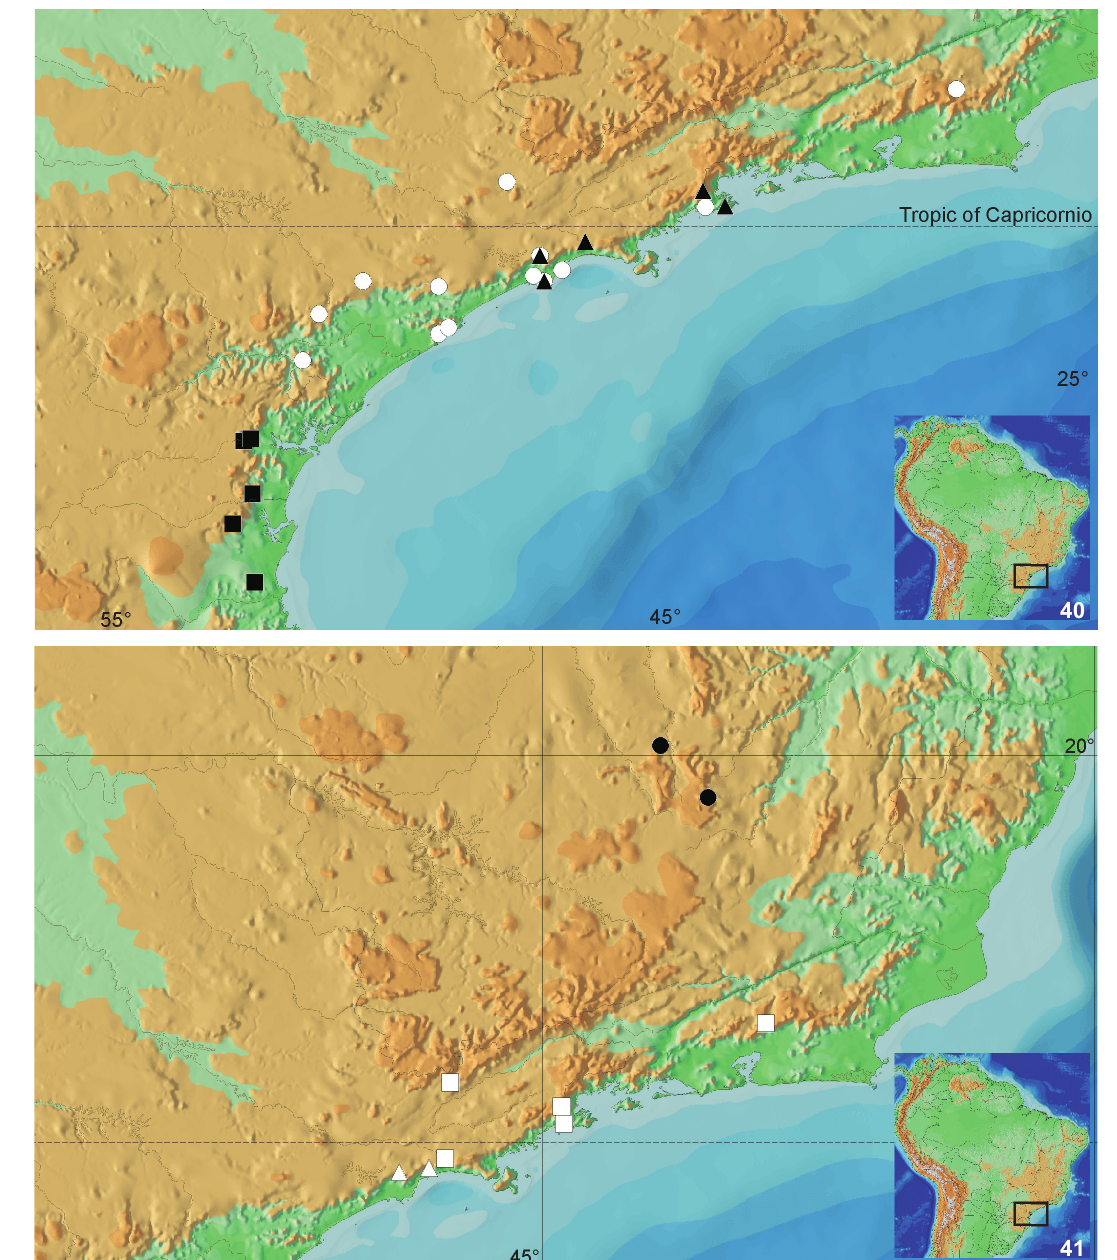
Figures 40-41. Geographical distribution records of Longiperna species: ( (cid:132) ) L. insperata , ( (cid:83) ) L. kuryi sp.n. , ( (cid:99) ) L. concolor , ( (cid:133) ) L. cancellata , ( (cid:85) ) L. coxalis , ( (cid:122) ) L. trembao sp.n.